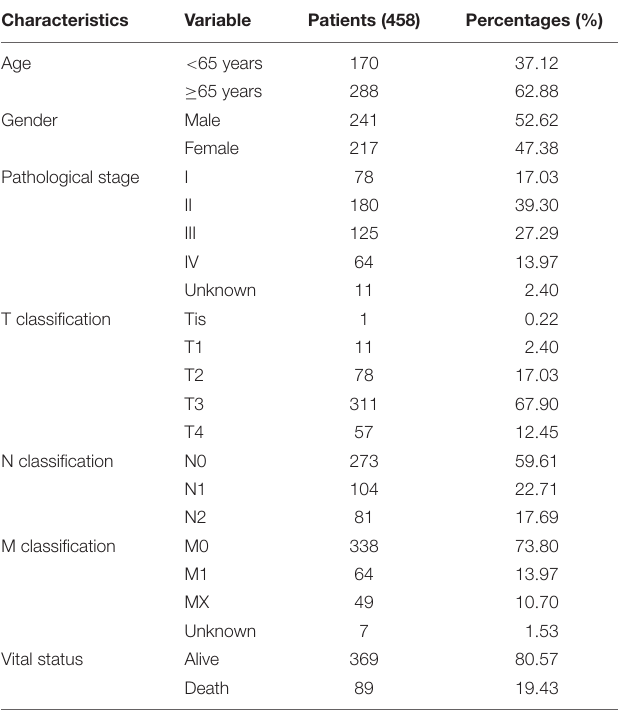
TABLE 1 | Characteristics of patients with colorectal cancer (CRC) [colon adenocarcinoma (COAD) and rectum adenocarcinoma (READ)] in TCGA database. Characteristics